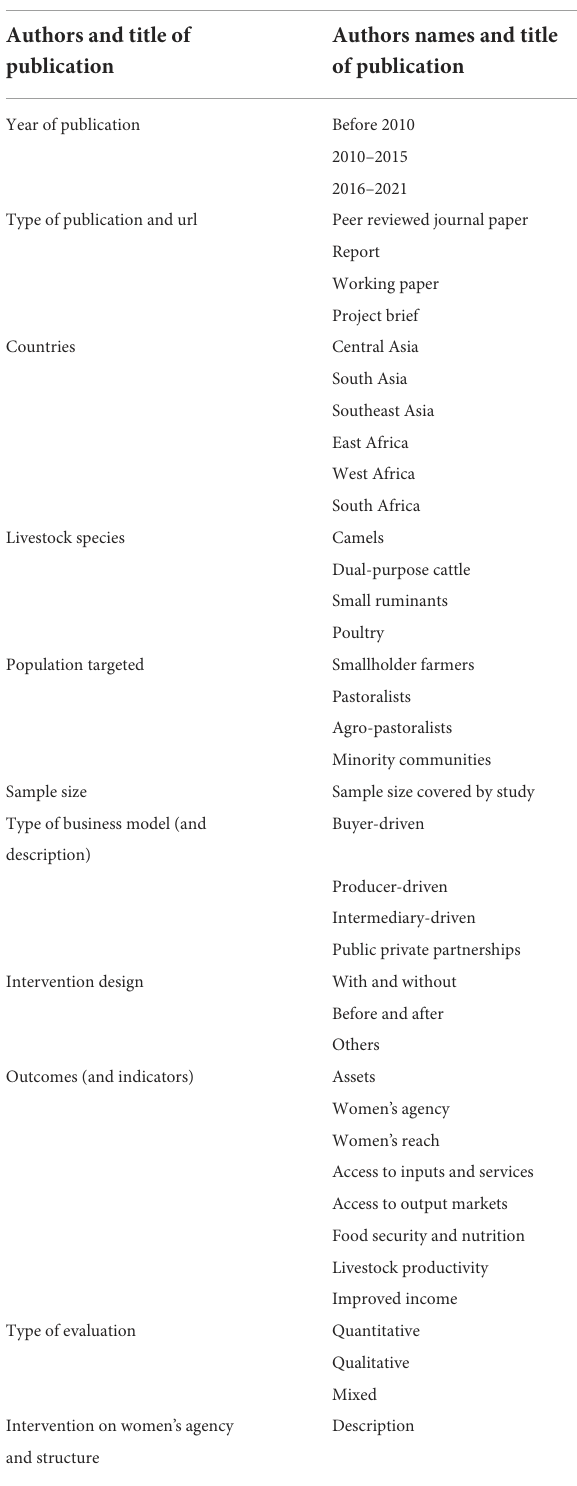
TABLE 2 Data extraction